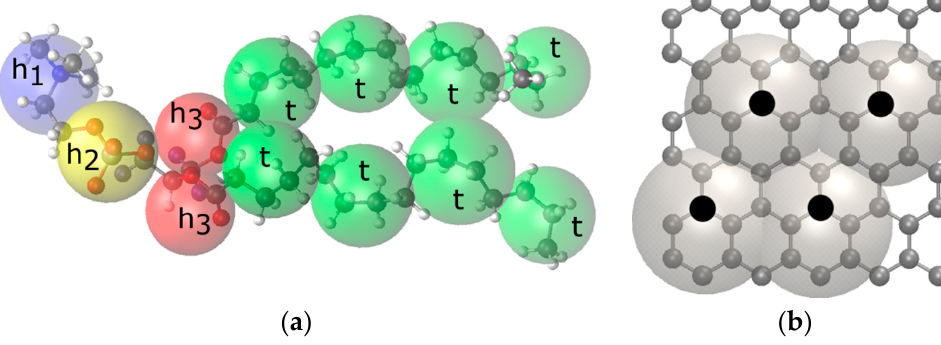
Figure 1. The mapping scheme adopted in this work for ( a ) dipalmitoylphosphatidylcholine (DPPC) and ( b ) carbon nanotubes. Each DPPC molecule is lumped into 12 beads: four head groups (h 1 , h 2 , and h 3 ) and eight tail groups (t). The black points in panel ( b ) represent the centers of beads. The DPD interaction parameters for DPPC were recently parameterized in Ref.